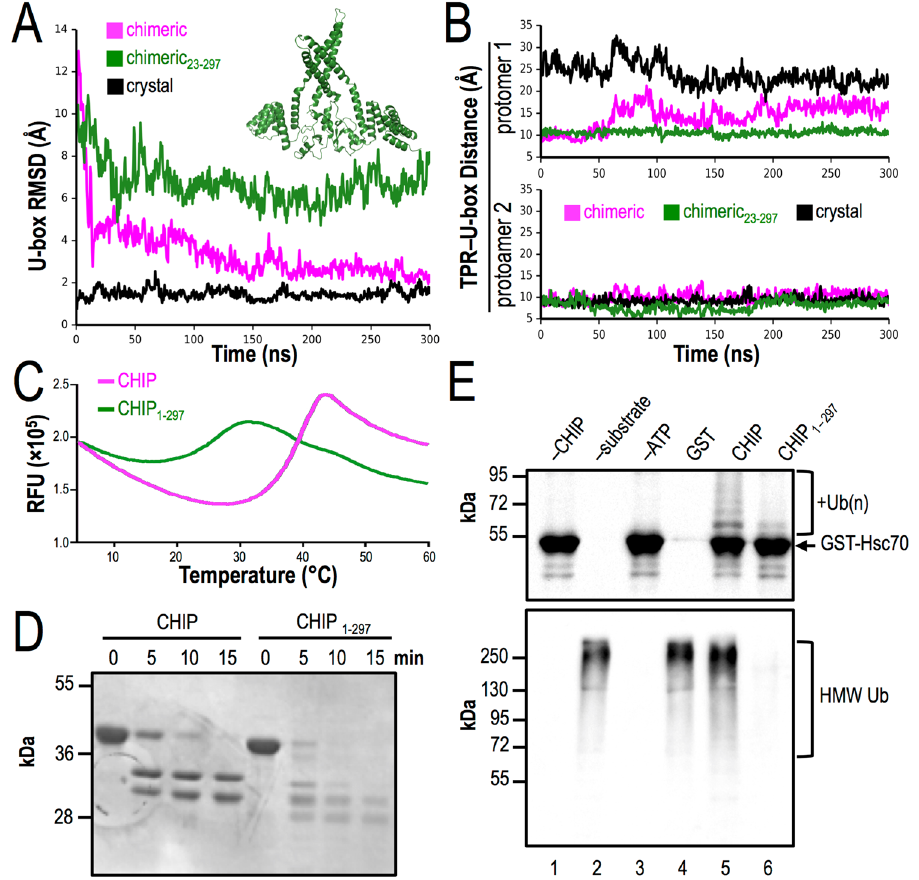
Figure 6. The C-terminus is critical for CHIP assembly and function. ( A ) Average of the three independent MDS show that U-boxes in truncated C-terminal CHIP 23–297 can reach the recognition site, but do not progress to the full dimer within the time scale of our simulations. Inset shows a representative snapshot of CHIP 23–297 . ( B ) TPR-U-box separation shows that their binding interface is not disrupted, and both E2 sites remained buried. ( C ) Thermal unfolding assays that measure SYPRO dye binding (thermofluor) shows that the truncated mutant is destabilized by ~12.5 °C compared to full-length CHIP. ( D ) Limited proteolysis assay shows decreased stability of CHIP 1–297 . ( E ) CHIP 1–297 substrate ubiquitination (top) and auto-ubiquitination (bottom) are significantly